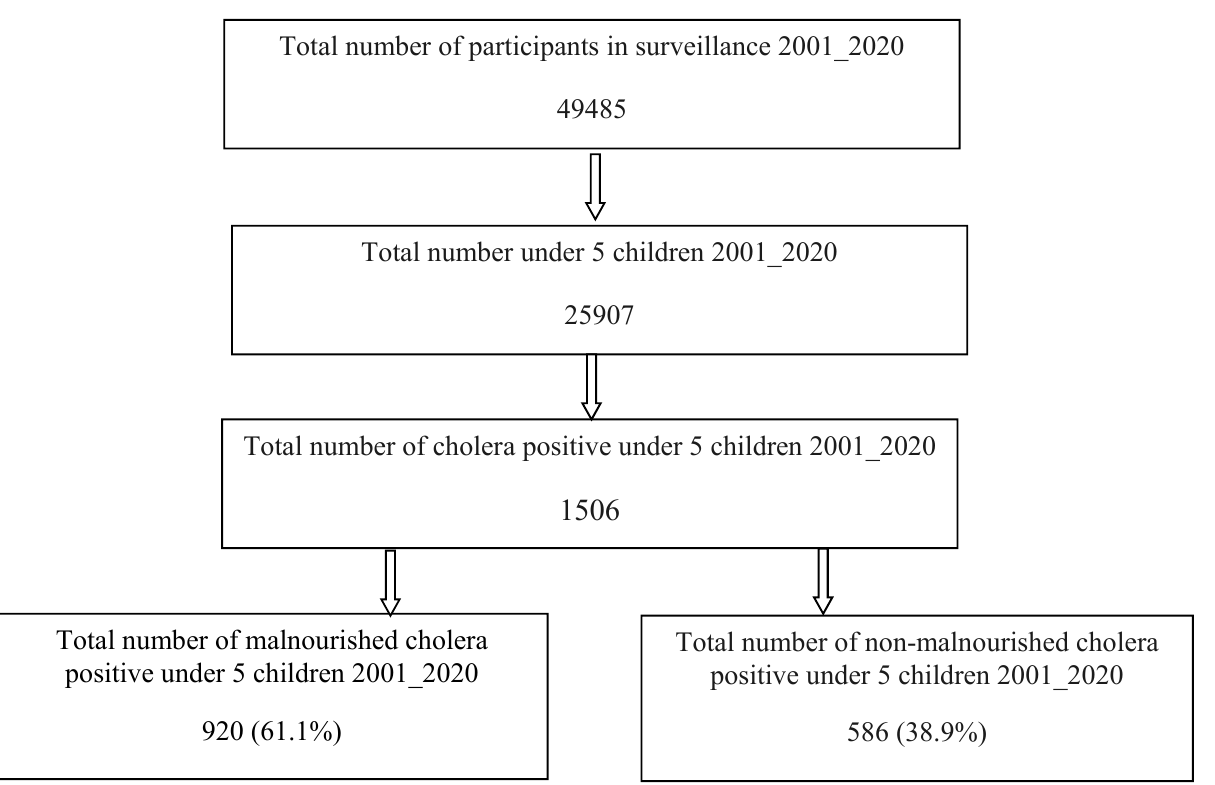
Figure 1. Showing the flow chart for selecting the cases and